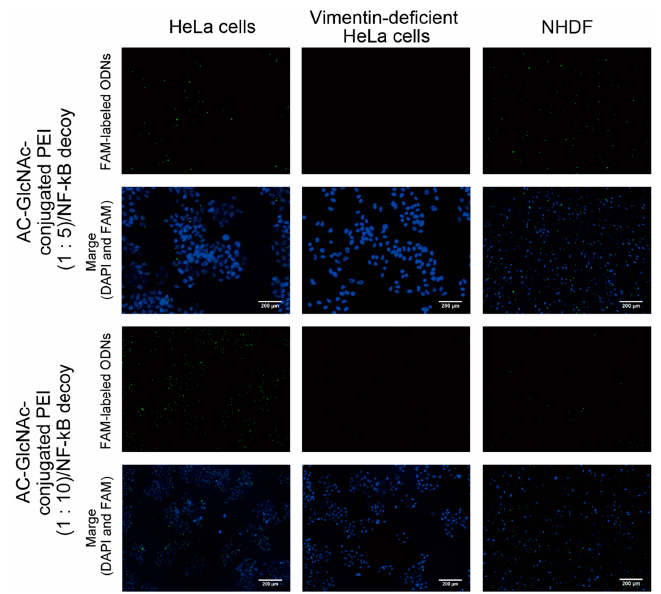
Figure 6. Micrographs of the interactions between AC-GlcNAc-conjugated polyethyleneimine (PEI)/carboxyfluorescein (FAM)-labeled NF- κ B decoy oligonucleotide (ODN) complexes and HeLa cells, vimentin-deficient HeLa cells, or normal human dermal fibroblasts (NHDFs). The complexes and nuclei are indicated by green and blue (4 ′ ,6-diamidino-2-phenylindole (DAPI) nuclear staining), respectively. Scale bar indicates 200 µm.